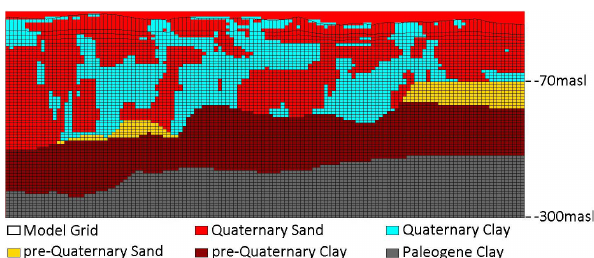
Fig. 2. Cross section with model grid and training image geolog- ical structure. Location on plain view is shown in Fig. 1. Vertical exaggeration is